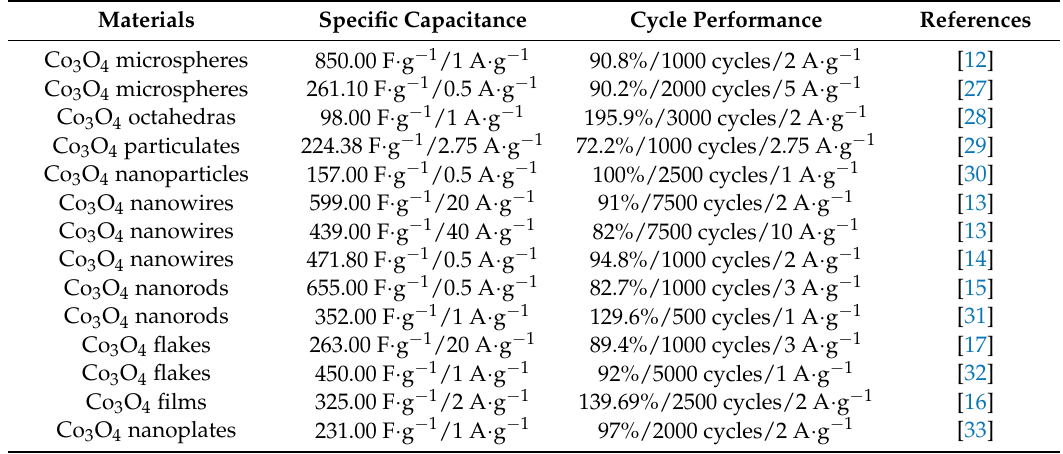
Table 1. The specific capacitance of Co 3 O 4 reported in some related